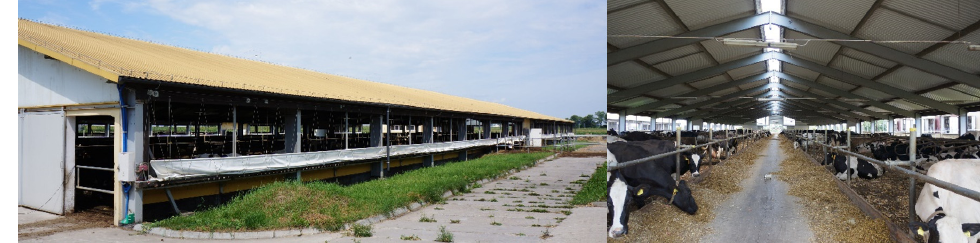
Figure 3. The studied barn for dairy cattle (authors photo).